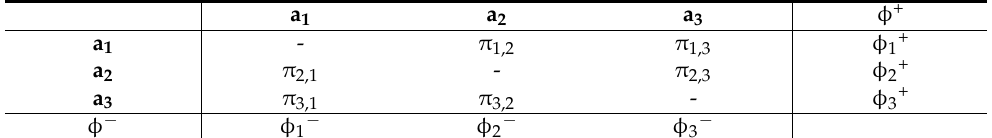
Table 6. PROMETHEE matrix with outranking relations and input and output flows